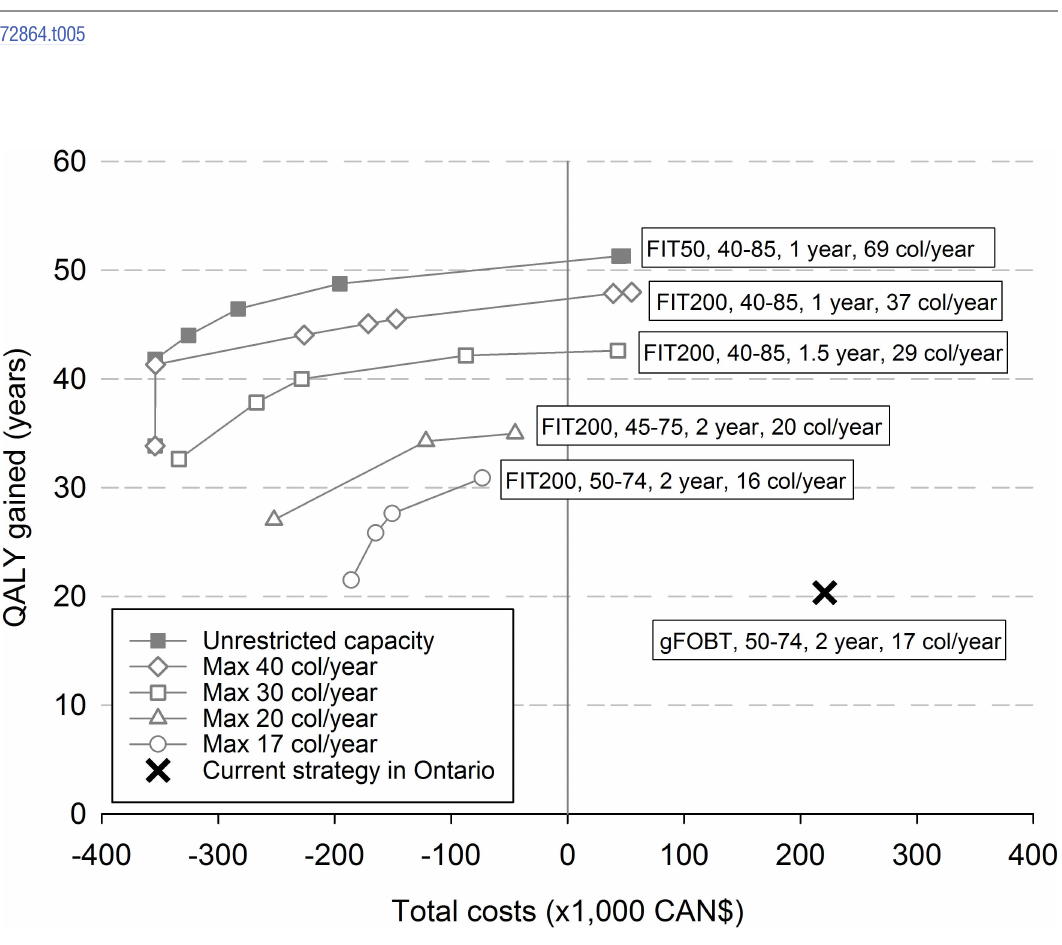
Fig 2. Efficient frontiers for different levels of colonoscopy capacity. Costs and QALYs gainedper 1,000 participants, comparedto no screening.QALY: qualityadjusted life year; gFOBT: guaiacfecal occult blood test; FIT: fecal immunochemicaltest; Col/year: number of colonoscopies requiredper 1,000 participantsper year. Strategies are varying by age at starting screening,age at stopping screening, screeninginterval, and FIT cut-off level. For each level of available colonoscopy capacity (maximal 17, 20, 30, 40 colonoscopies per 1,000 participantsper year and unrestricted colonoscopy capacity) the cost-effective strategies are connected by their respectiveefficient frontier. The text boxes beside each frontier present the screeningstrategy (test, age range, intervaland